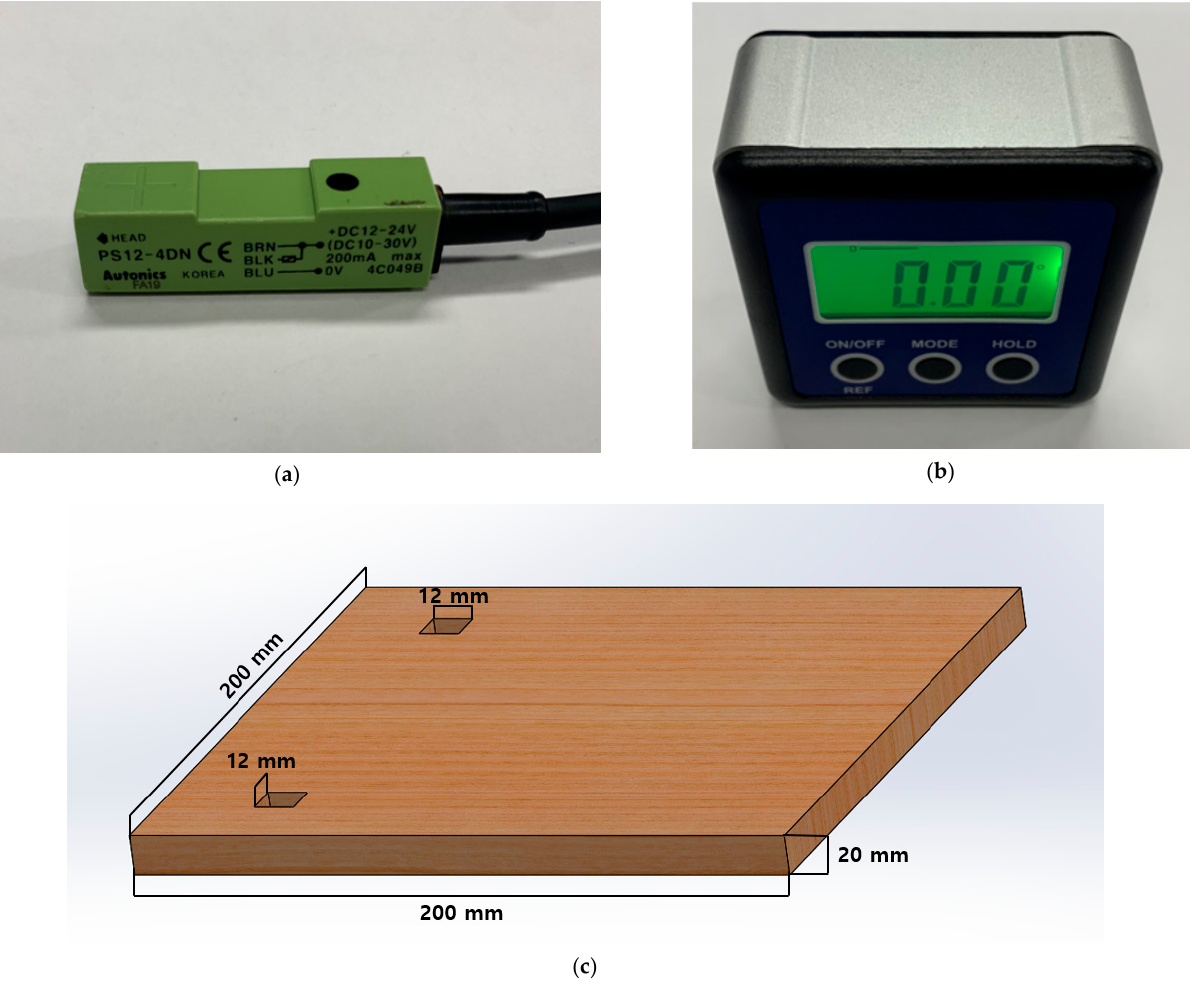
Figure 9. Shapes of products used in the test platform: ( a ) metal proximity sensor; ( b ) digital level; ( c ) slope plate. Table 4. Specifications of the metal proximity sensor.